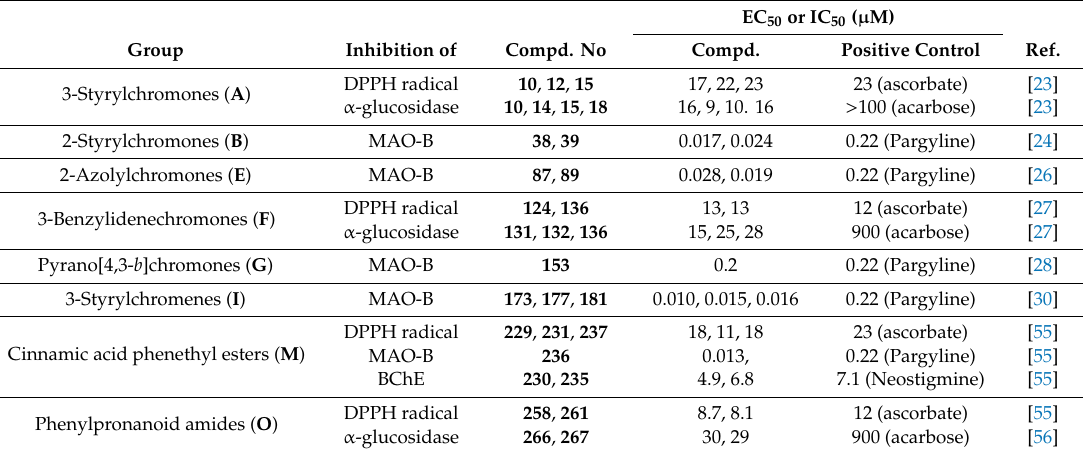
Table 7. Oher biological activities of chromones, esters, and